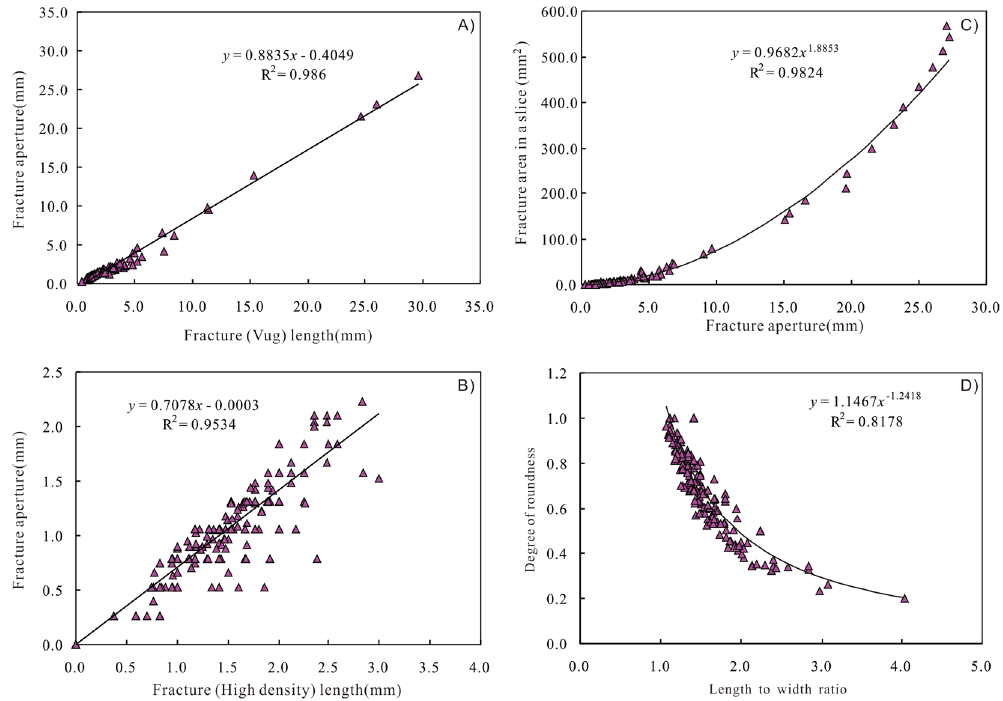
Figure 4. Crossplots showing the relationships between ( A ) open fracture aperture and fracture length; ( B ) calcite-filled fracture aperture and fracture length; ( C ) fracture area in a slice and fracture aperture; ( D ) Crossplot of degree of roundness and length to width ratio for open fractures.